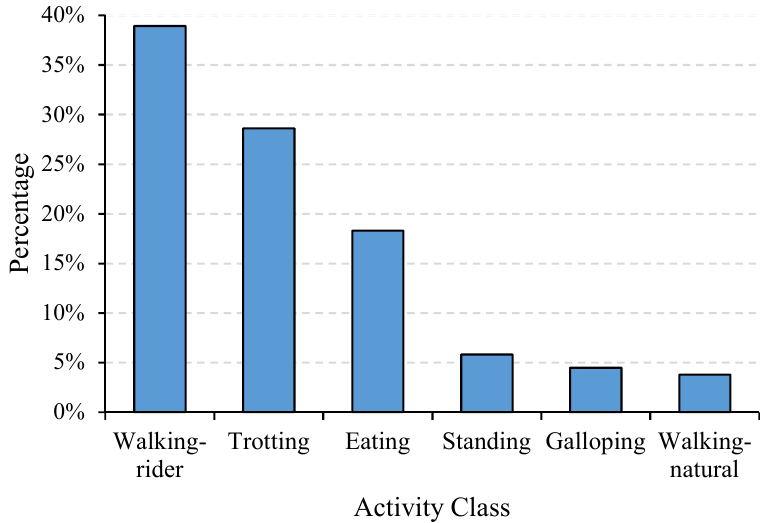
Figure 1. Histogram of class distribution.